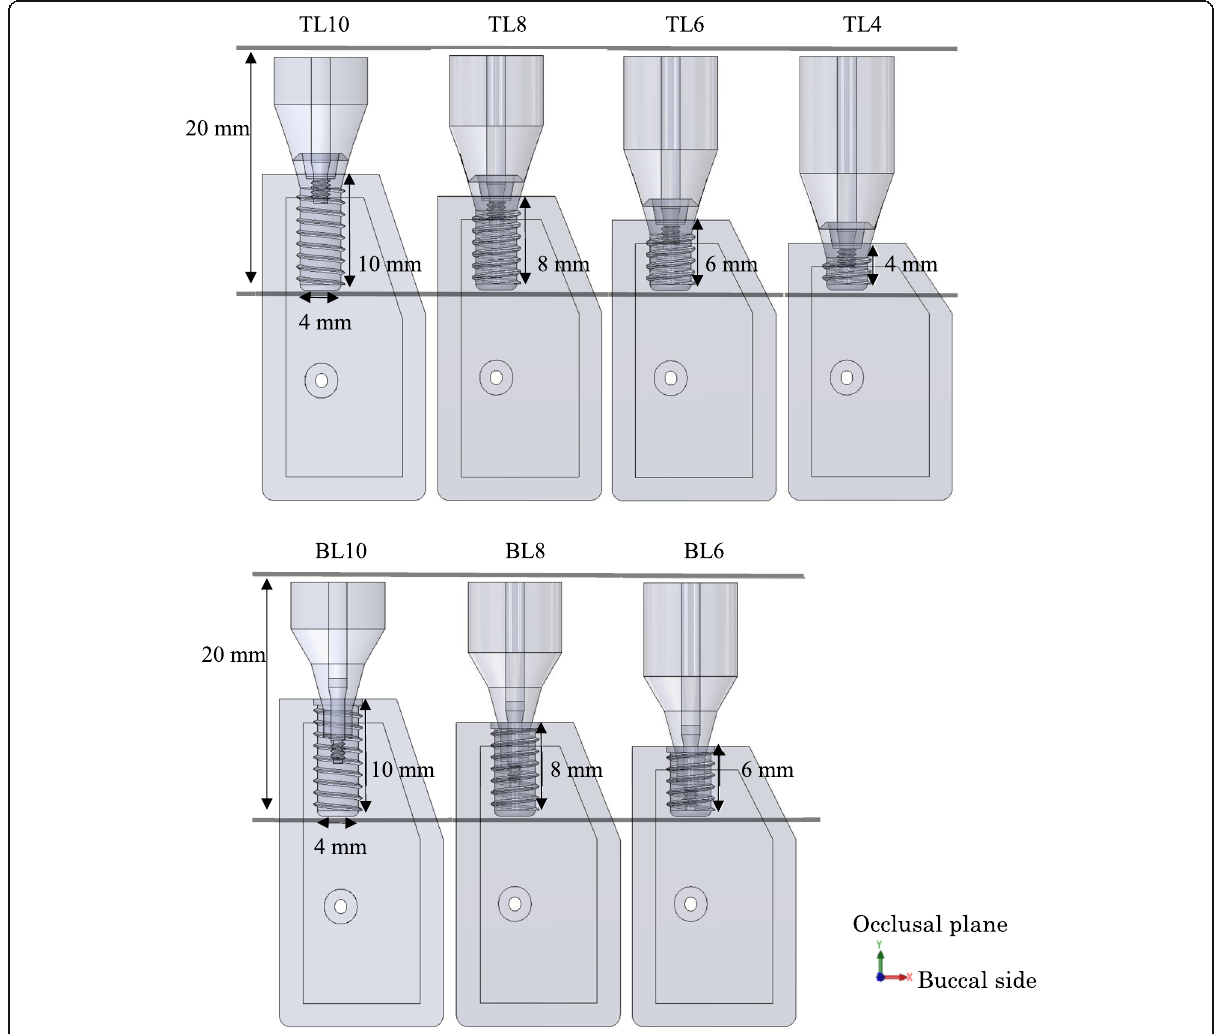
Fig. 2 Models of different implant body